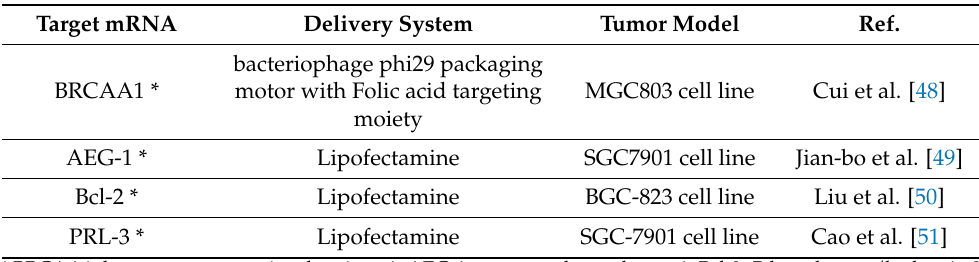
Table 2. siRNA employment in stomach cancer. Target